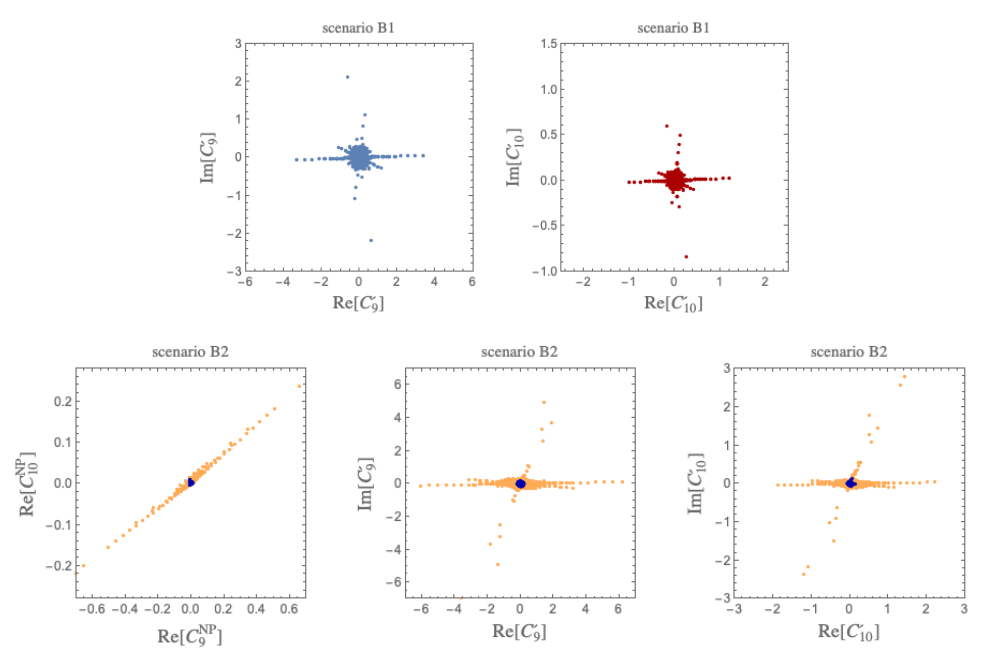
Figure 8 . Scenarios B1 (upper plots) and B2 (lower plots). Wilson coe(cid:14)cients that appear in the b ! s‘ + ‘ (cid:0) e(cid:11)ective Hamiltonian. Only those sensibly di(cid:11)erent from zero are displayed: C 0 C 0 (not present in the SM) in scenario B1 (upper plots) and in B2 (lower middle and right plots). 10 In the case of B2 deviation from the SM values of Re[ C 9 ] and Re[ C 10 ] are also shown (lower left